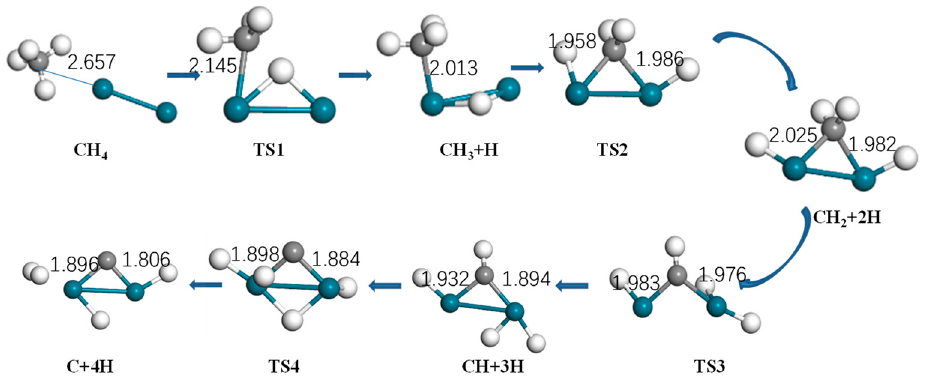
Figure 4. Optimized structure of reactants, intermediates, products, and the transition state of methane activation by Pd 2 (turquoise: Pd, gray: C, white: H).